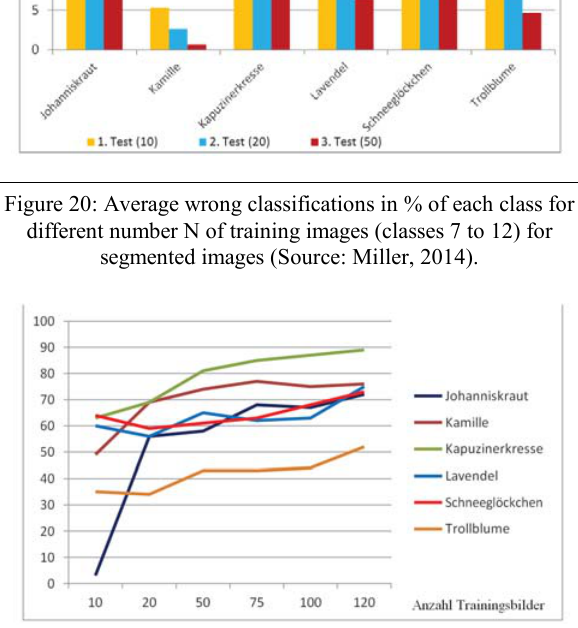
Figure 21: Average test accuracy in % of the flowers of classes 7 to 12 depending on the number of training images (Source: Miller, 2014).